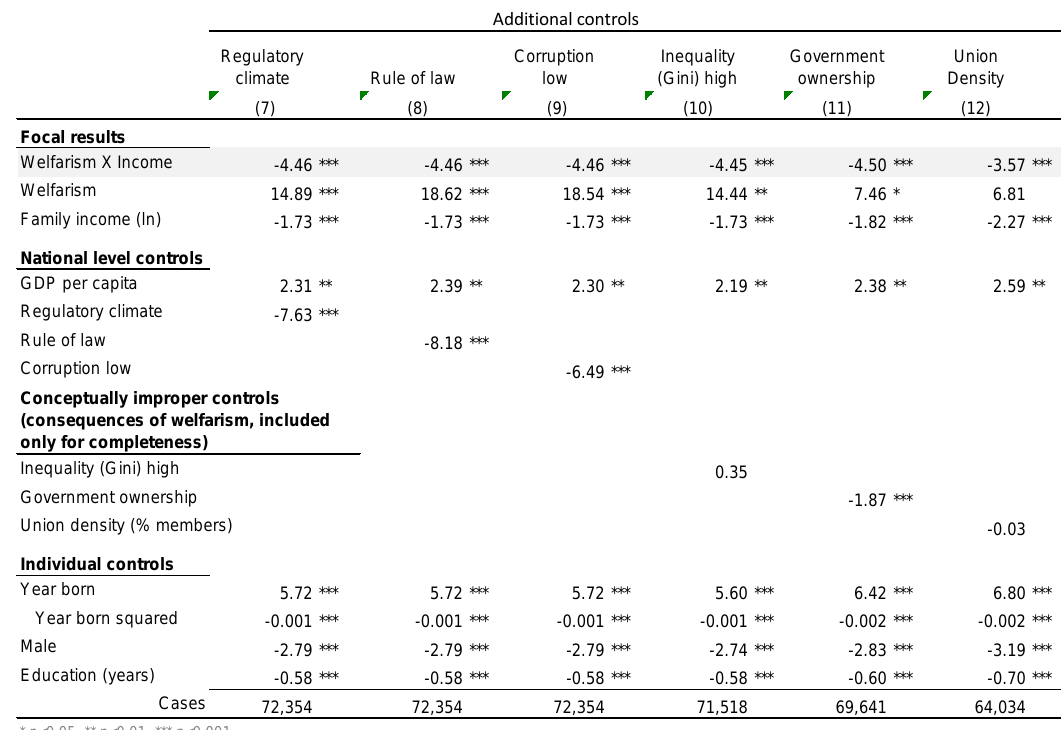
Figure A11. Additional national level controls make little difference to the key results. Influences on attitudes toward redistribution. Multilevel estimates, metric coefficients. 30 European nations. (Table continues below).